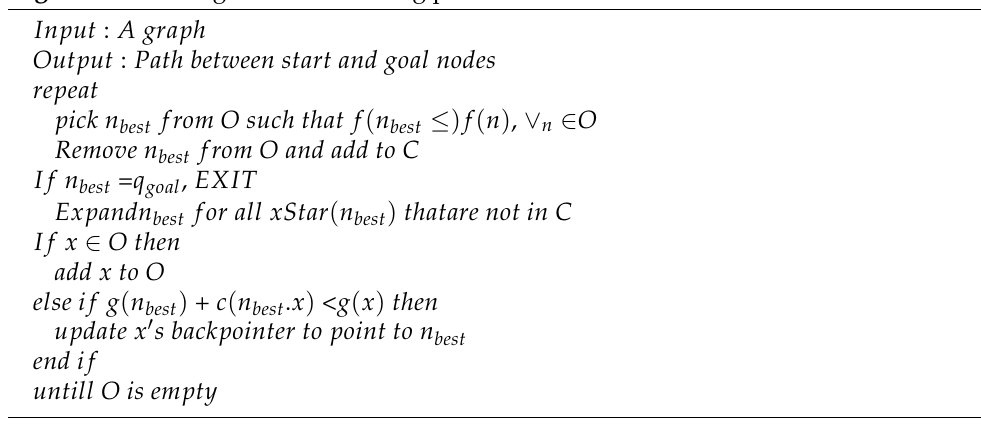
Algorithm 2 A* Algorithm for finding path